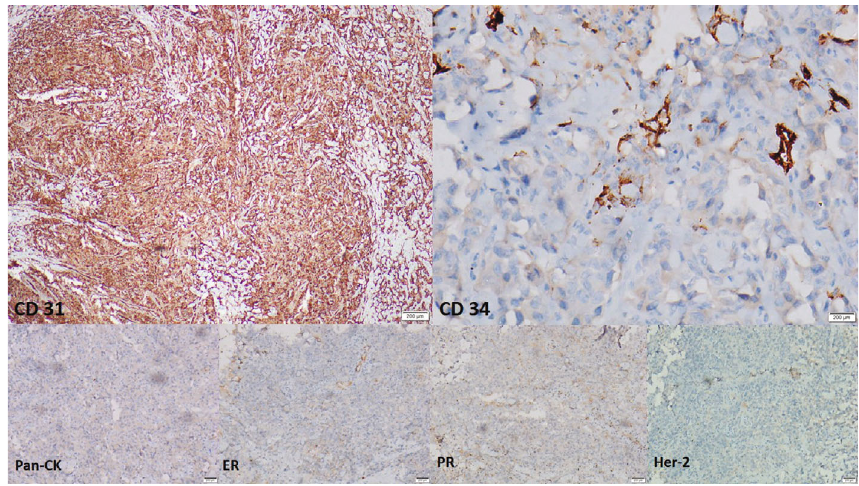
Figure 3: Immunohistochemical analyses showing strong and di ff use cytoplasmic and membrane positivity for CD 31 and occasional cytoplasmic and membrane positivity for CD 34. Tumour cells were negative for PanCK., ER, PR, and